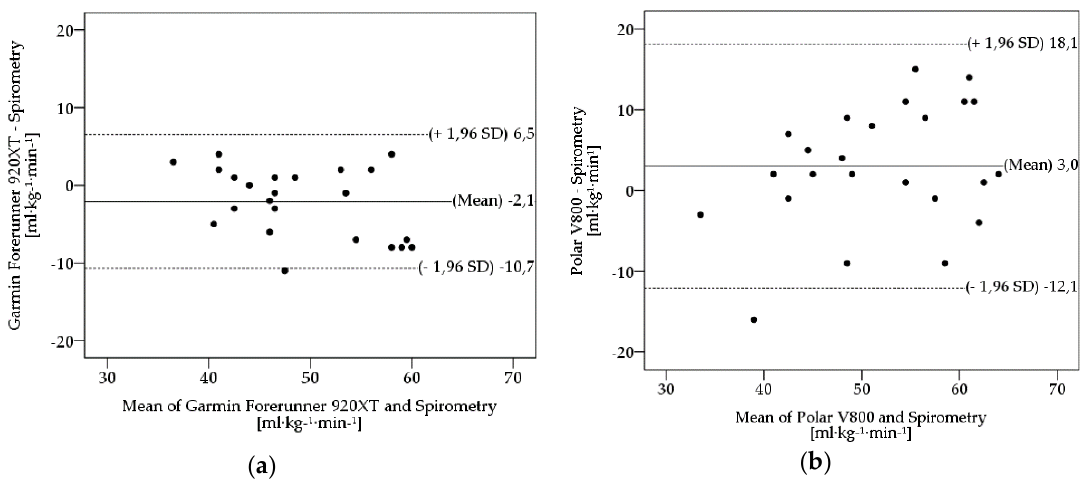
Figure 1. Bland-Altman plots of Spirometry VO 2max for ( a ) Garmin Forerunner 920 XT, ( b ) Polar V 800. Limits of agreement (LoA) were calculated as mean ± 1.96 x SD. Mean biases are depicted as solid line; LoA are depicted as dashed lines.